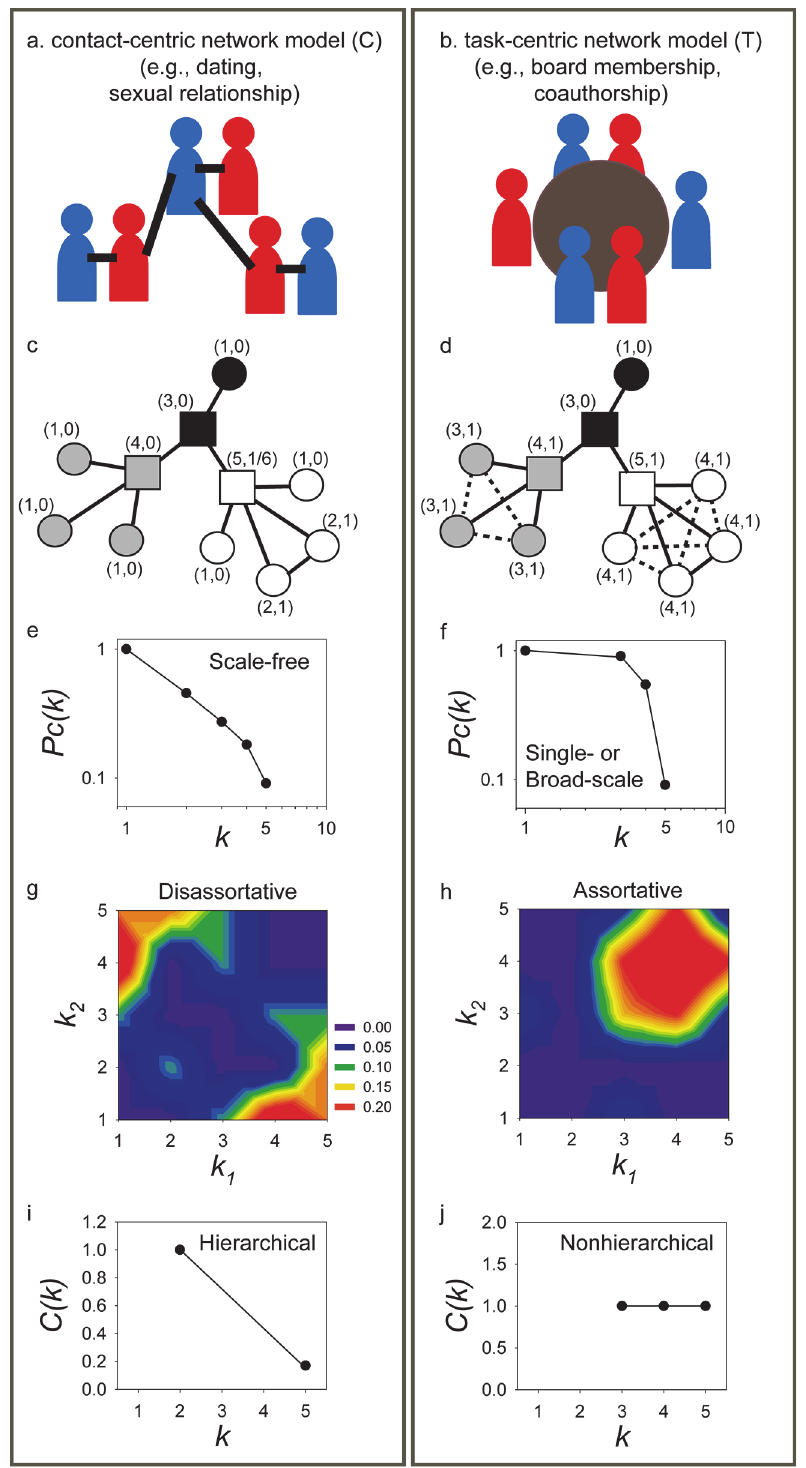
Fig 1. Illustrative examples of network dichotomy. Two broad classes of networks naturally occur in real world settings based on whether interactions between entities are intrinsically pairwise (left panel) or based on groups (right panel). Examples in human social networks might include (a) dating or sexual relationships, and (b) board memberships or co-authorships of scientific papers. (c and d) indicate small toy examples for